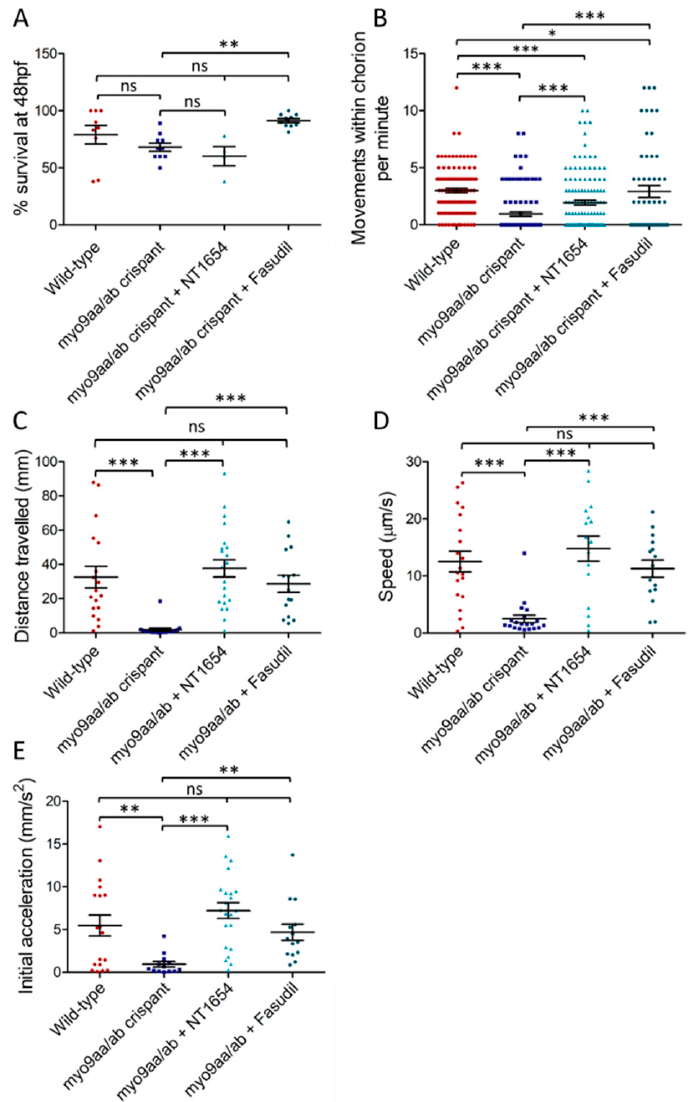
Figure 2. Survival and movement of myo9aa / ab crispant fish. ( A ) Survival of wild-type ( n = n = 9 repeats), myo9aa / ab crispant ( n = n = 10 repeats), and NT1654 (0.15 ng, n = 4 repeats) or fasudil-treated (10 µ m, n = 10 repeats) crispant zebrafish at 48 hpf, expressed as a percentage of fish in each group at 0 hpf. ( B ) Full chorion movements performed by wild-type ( n = 110 fish), myo9aa / ab crispant ( n = 104 fish), and NT1654 (0.15 ng, n = 129 fish) or fasudil-treated (10 µ m, n = 54 fish) crispant zebrafish at 24 hpf. ( C ) Distance, ( D ) Speed, and ( E ) Initial acceleration were quantified following a tactile-stimulation assay in the zebrafish. Wild-type ( n = 18 fish), myo9aa / ab crispant ( n = 19 fish), and NT1654 (0.15 ng, n = 22 fish) or fasudil-treated (10 µ m, n = 15 fish) crispant zebrafish were subject to the assay at 48 hpf. Error bars = mean ± S.E.M. * p ≤ 0.05, ** p ≤ 0.01, *** p ≤ 0.001, ns = not significant, Kruskal-Wallis